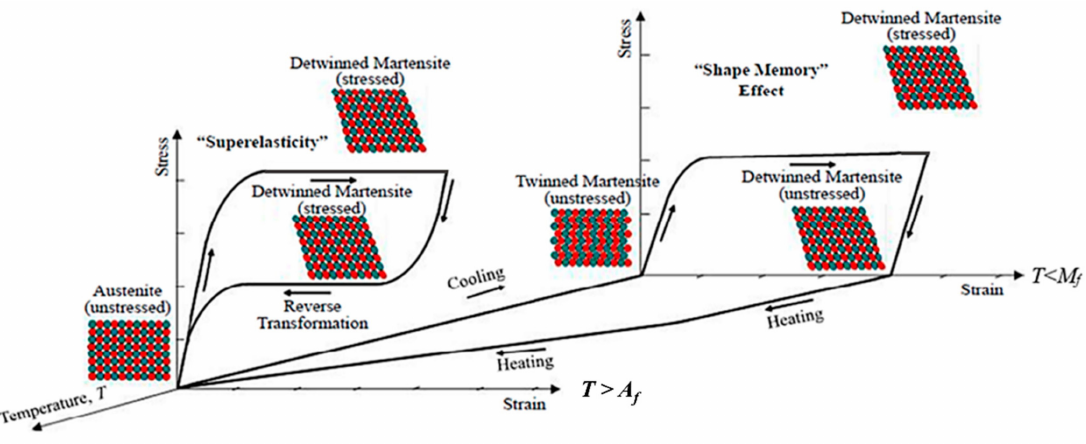
Figure 1. Shape memory alloys behavior influenced by phase transformations